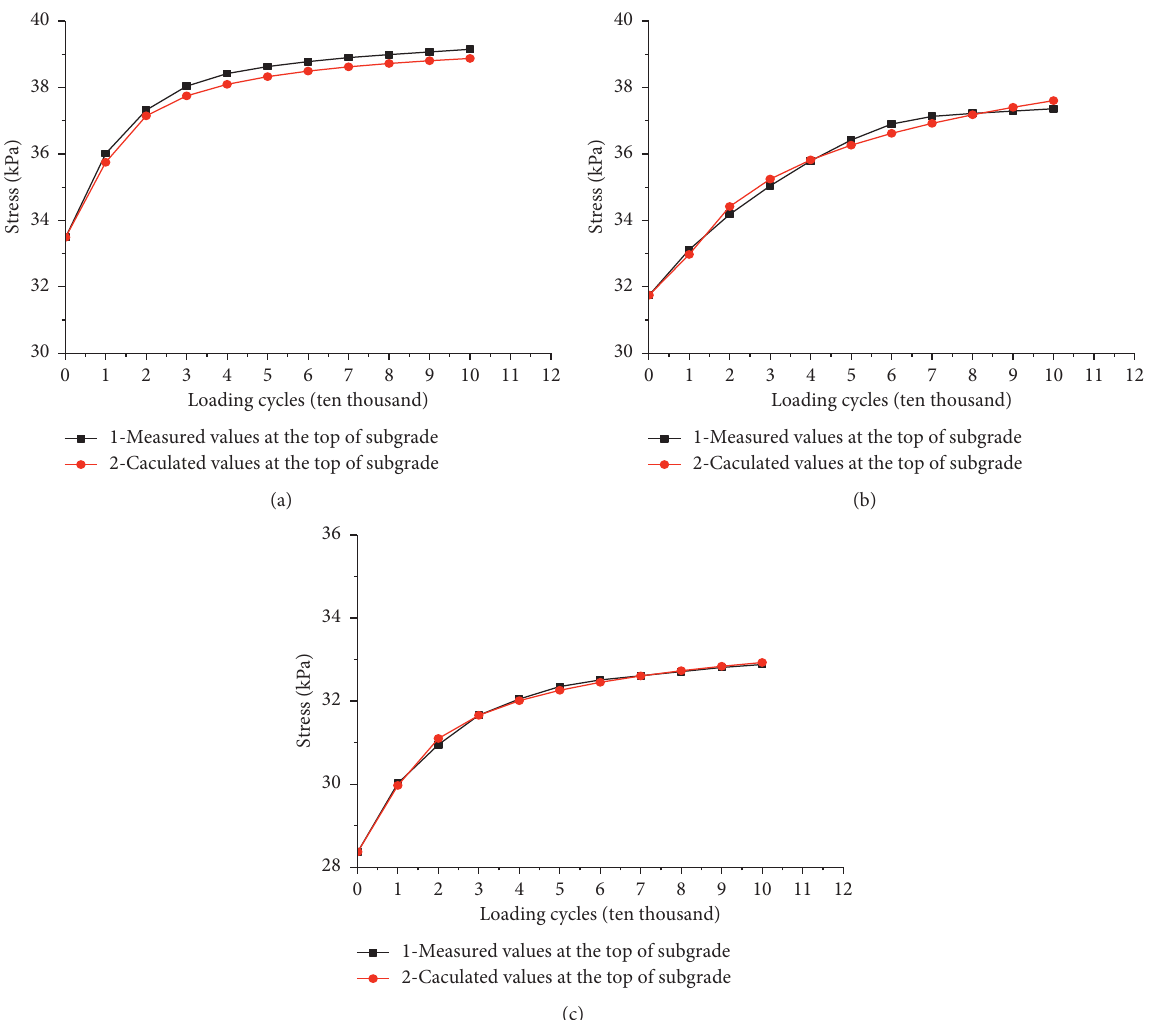
Figure 7: Comparison between the calculated and measured values of dynamic stress at the top of the subgrade under different loading cycles. (a) The moisture content of the foundation was 18%. (b) The moisture content of the foundation was 23%. (c) The moisture content of the foundation was